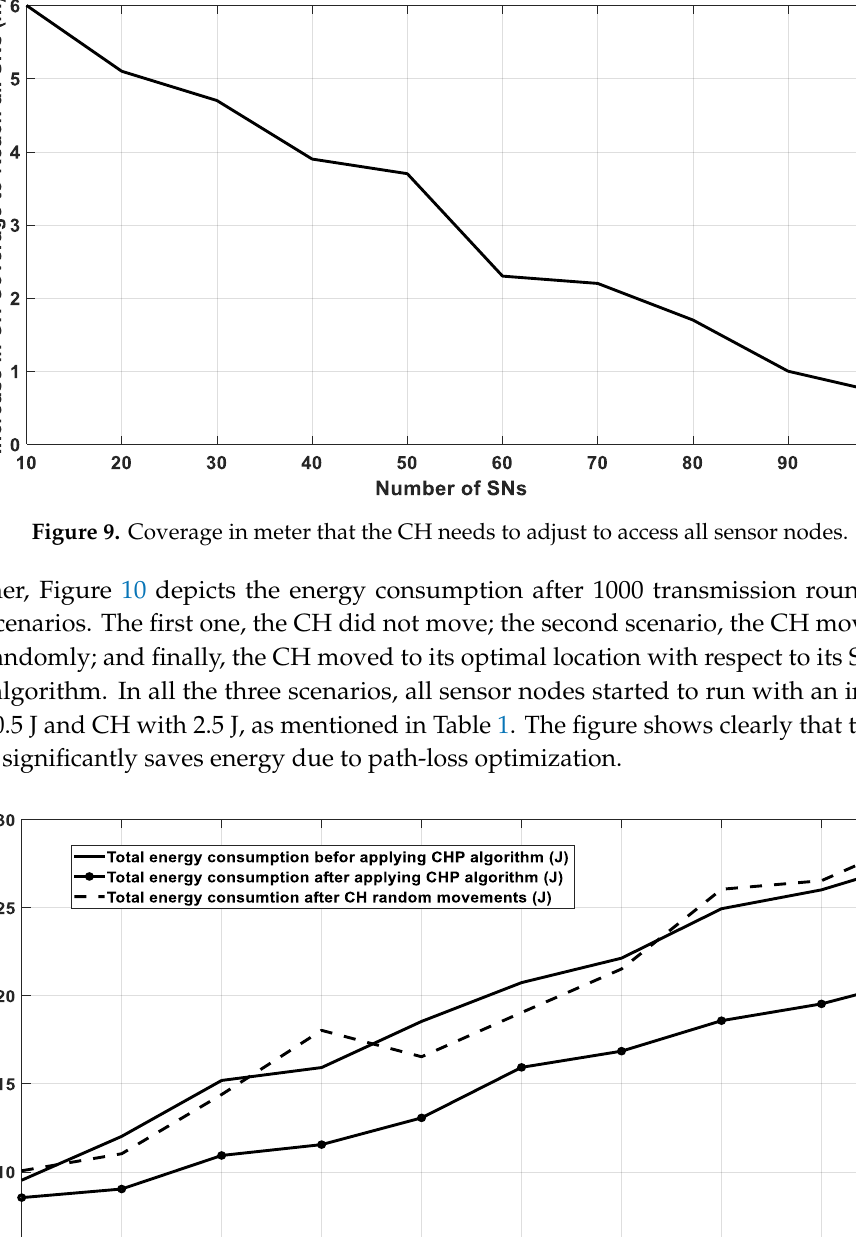
Figure 10. Energy consumption for all the SNs after 1000 rounds.